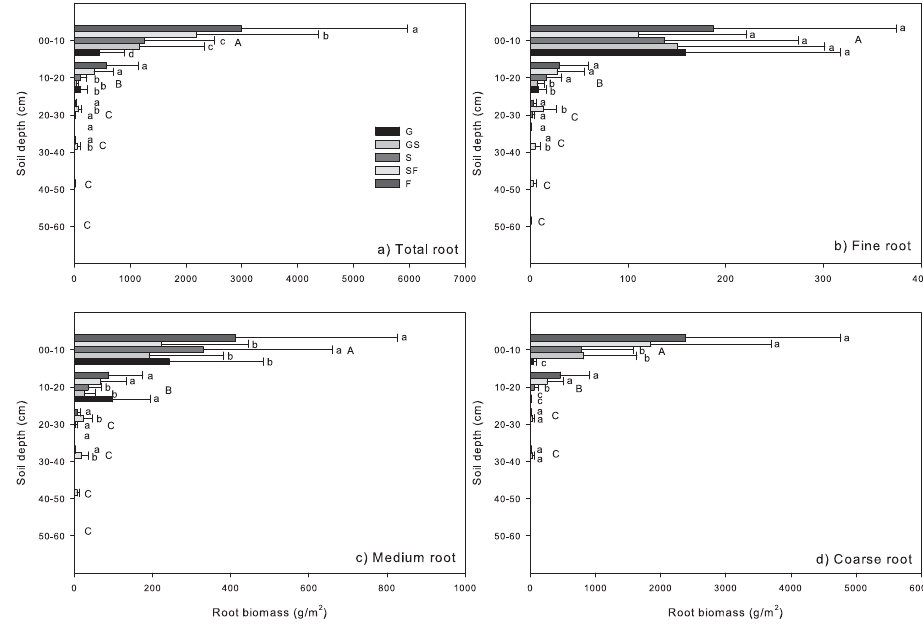
Figure 4. Root biomass in different land cover types: (a) total roots; (b) fine roots; (c) medium roots; and (d) coarse roots. F: mixed evergreen and deciduous forest; SF: scrub–tree forest; S: thorn–scrub shrubland; GS: grass–scrub tussock; G: grassland. The same letters above the error bars denote no significant differences and different letters denote significant differences. The lower cases are for various land cover types and the upper cases for various soil